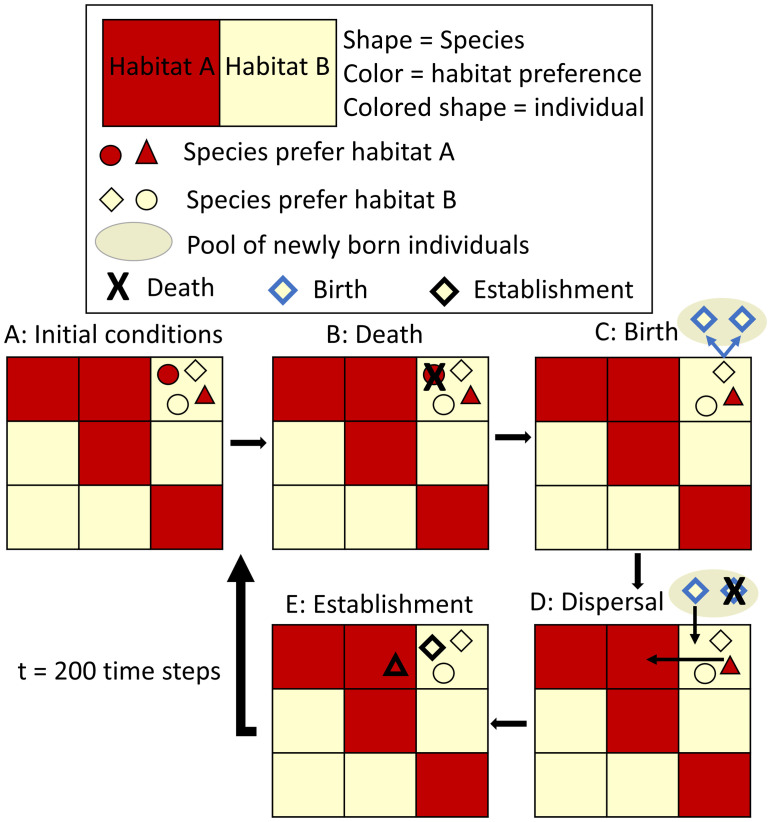
Schematic documenting the events that occur in a single time step of the simulation, including death, birth, dispersal, and establishment.See text for details.